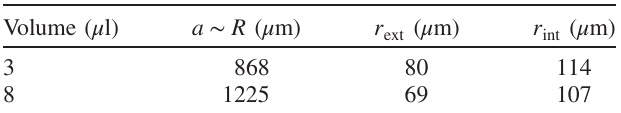
TABLE I. Geometric values obtained through confocal analysis.